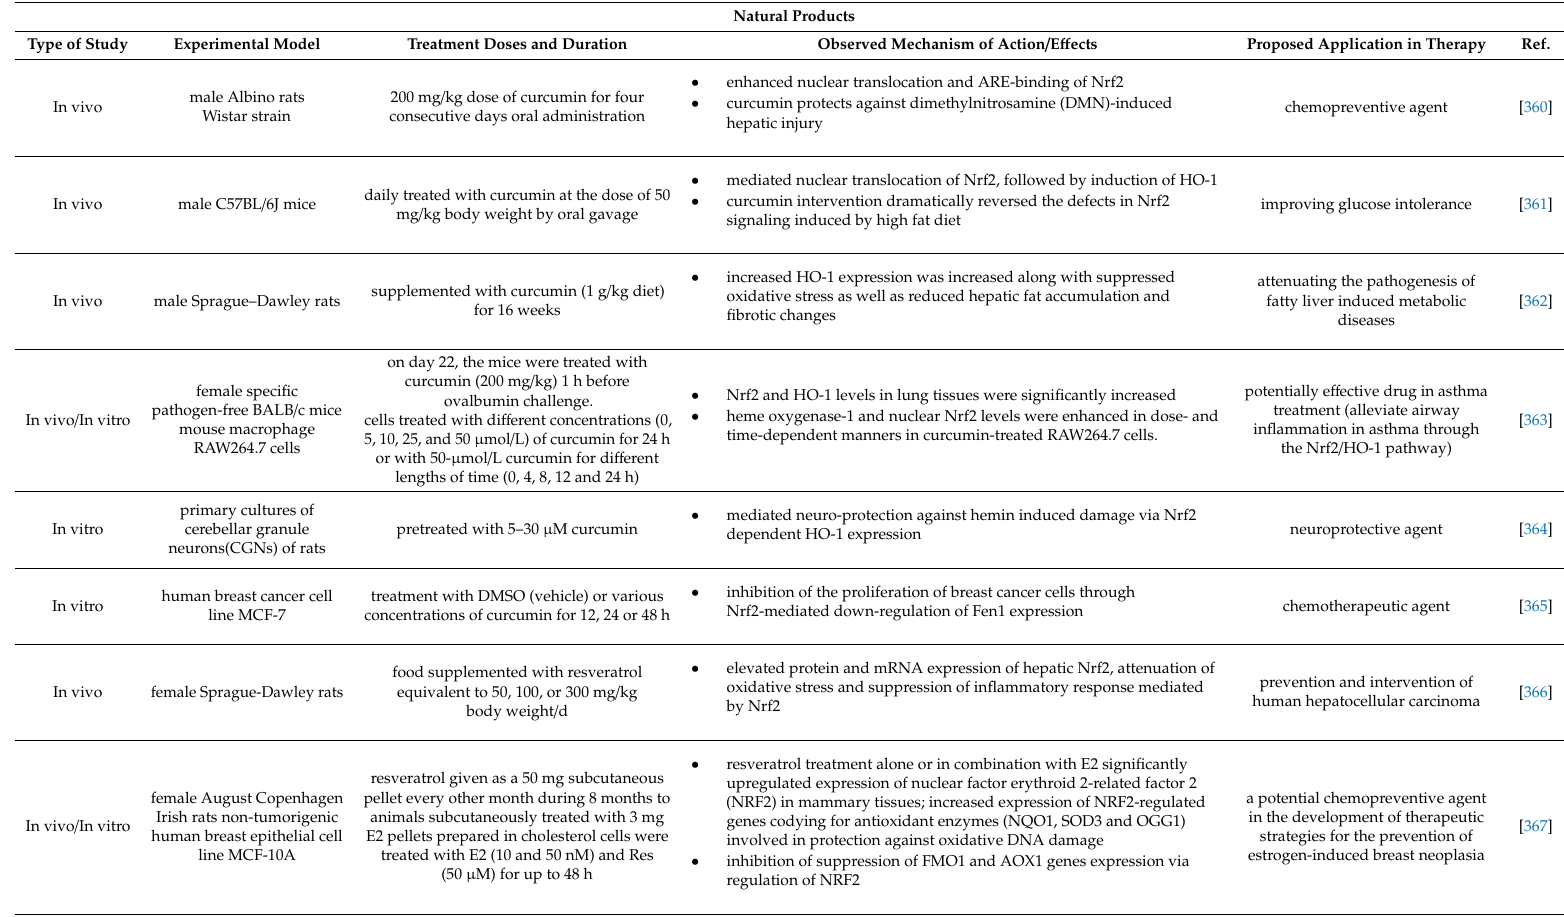
Table 2. Systematic presentation of studies on possible use of natural Nrf2 activators in therapy with possible mechanisms of action connected to Nrf2 activation